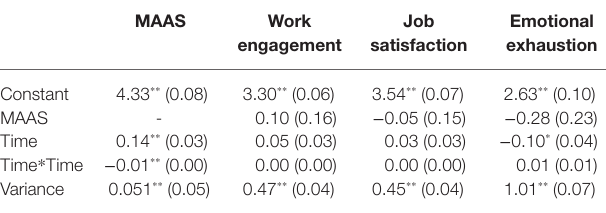
TABLE 5 | Curvilinear growth curve modeling results. MAAS Work engagement